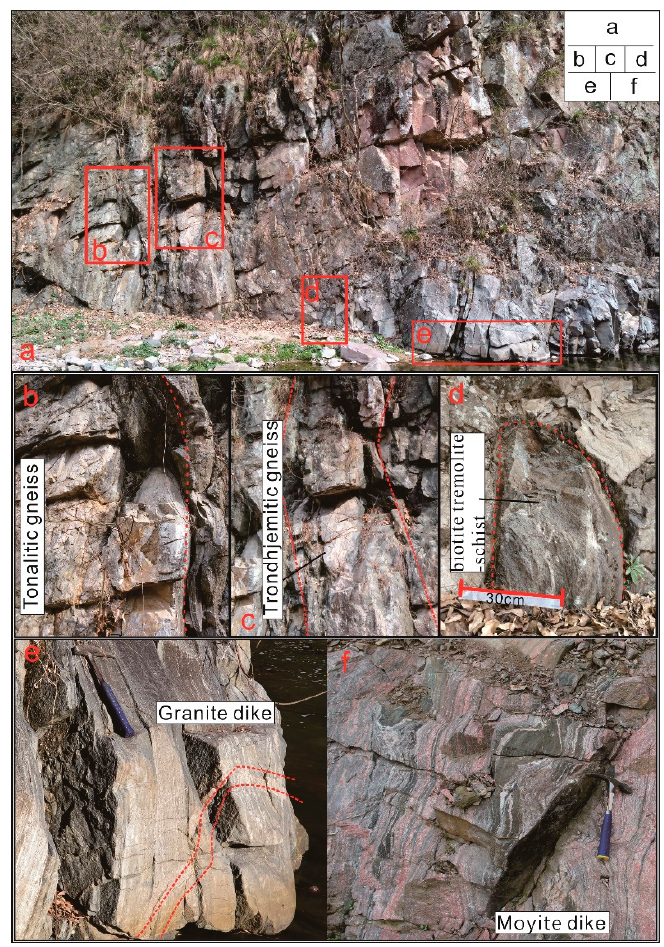
Figure 2. Field photographs of the Shuiyuesi granite–greenstone terrane showing outcrops of ( a ) the Taoyuan trondhjemite gneiss, ( b ) the tonalitic gneiss, ( c ) the trondhjemitic gneiss, ( d ) the biotite–tremolite schist, ( e ) a granite dike, and ( f ) the moyite dike.